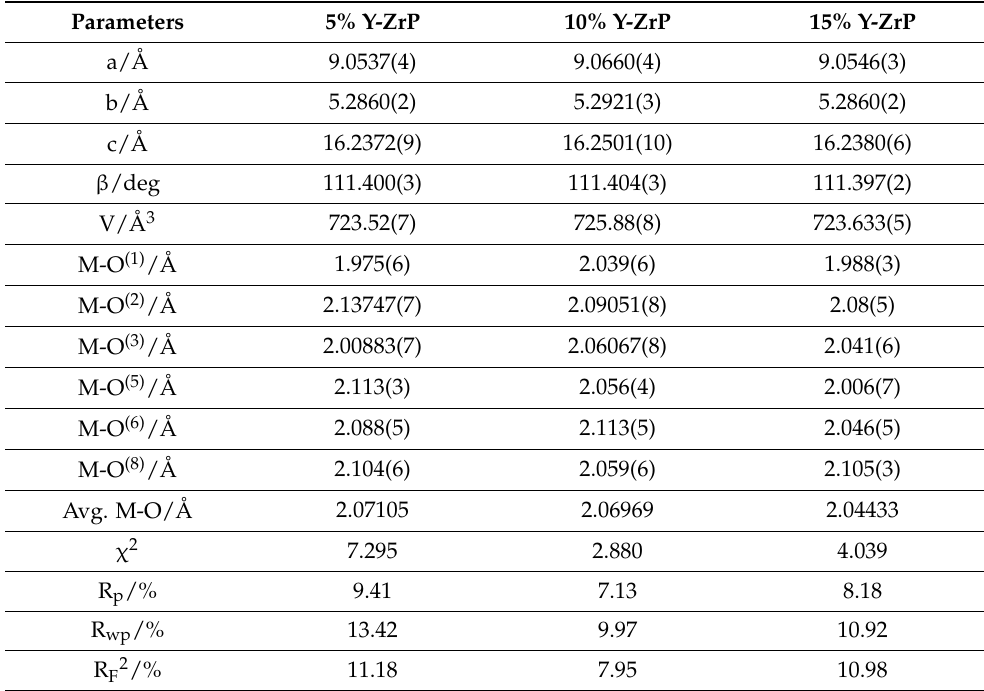
Table 2. Refined structural parameters for conventional